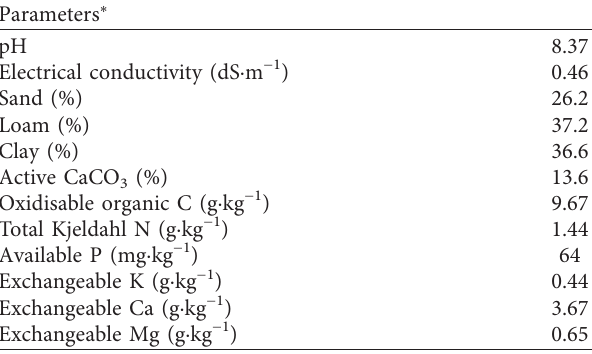
Table 1: Soil characteristics of the experimental